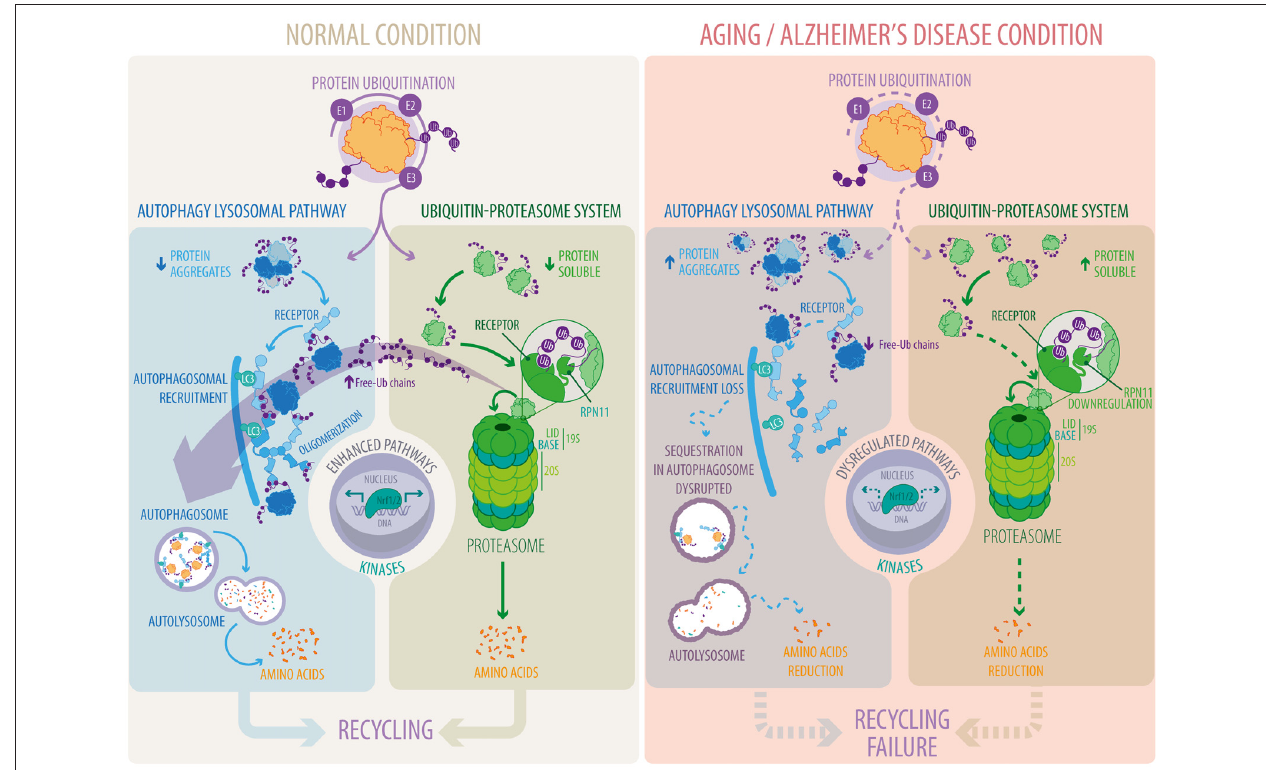
FIGURE 1 | Autophagy-lysosomal pathway (ALP) and ubiquitin-proteasome system (UPS) pathways under normal and pathological conditions. Proteins are tagged with ubiquitin conjugates through a sequential enzymatic mechanism involving three classes of enzymes, E1, E2 and E3. Under normal conditions , ubiquitylated substrates are recognized by ubiquitin receptors present in ALP and UPS pathways and efficiently eliminated. In the UPS, substrates are subsequently deubiquitylated by RPN11, a key step for substrate degradation and amino acid recycling. Free-Ub chains formed by RPN11 activity promote ALP function. Ubiquitin receptors in the ALP, in contrast to the UPS, form oligomers to facilitate substrate recognition and autophagosomal recruitment. Under aging and Alzheimer’s disease conditions there is a decrease in the function of the ALP and the UPS that reduces substrate degradation and amino acid recycling. Downregulation of RPN11 in Alzheimer’s disease (AD) decreases free-Ub chains disrupting substrate recognition, their recruitment into autophagosomes and their final degradation by the ALP. Altogether, leading to the accumulation of deleterious protein aggregates. Transcriptional regulation (Nrf1/2) and phosphorylation (kinases/phosphatases) play a crucial role in ALP and UPS function whereas their dysregulation is the focus of intense studies in aging and Alzheimer’s disease.